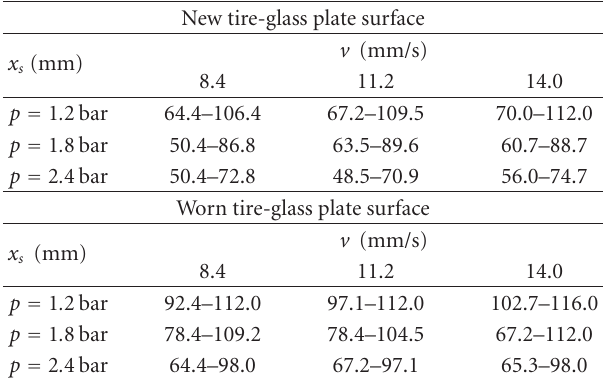
Table 3: The contact lengths for the slick tire rolling in a driven mode for the interval of normal loading F z = 2000 ··· 4000 N (from